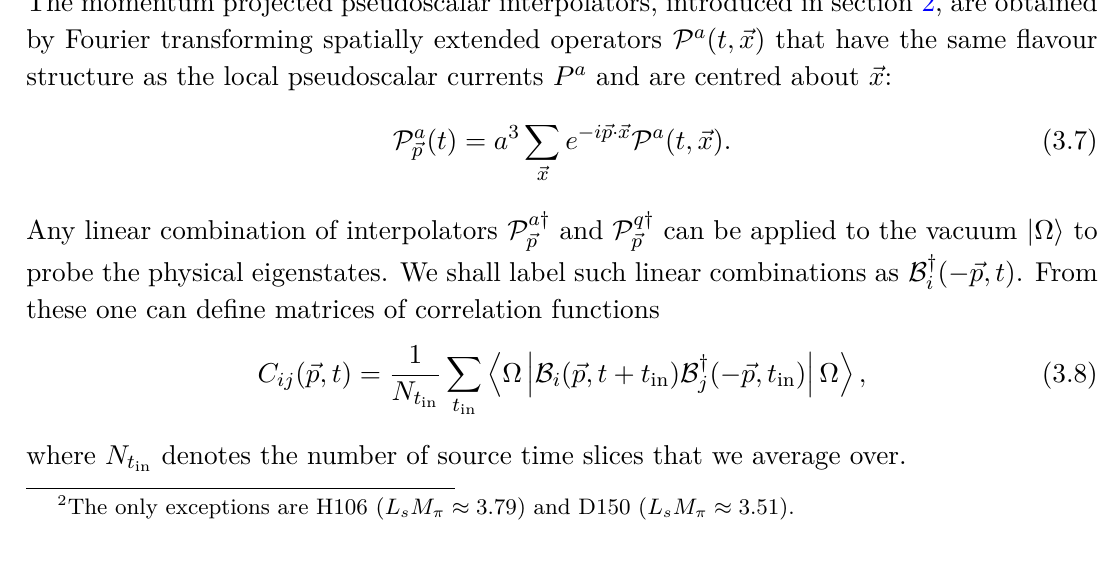
For t χ = 1 . 036(4) t ∗ 0